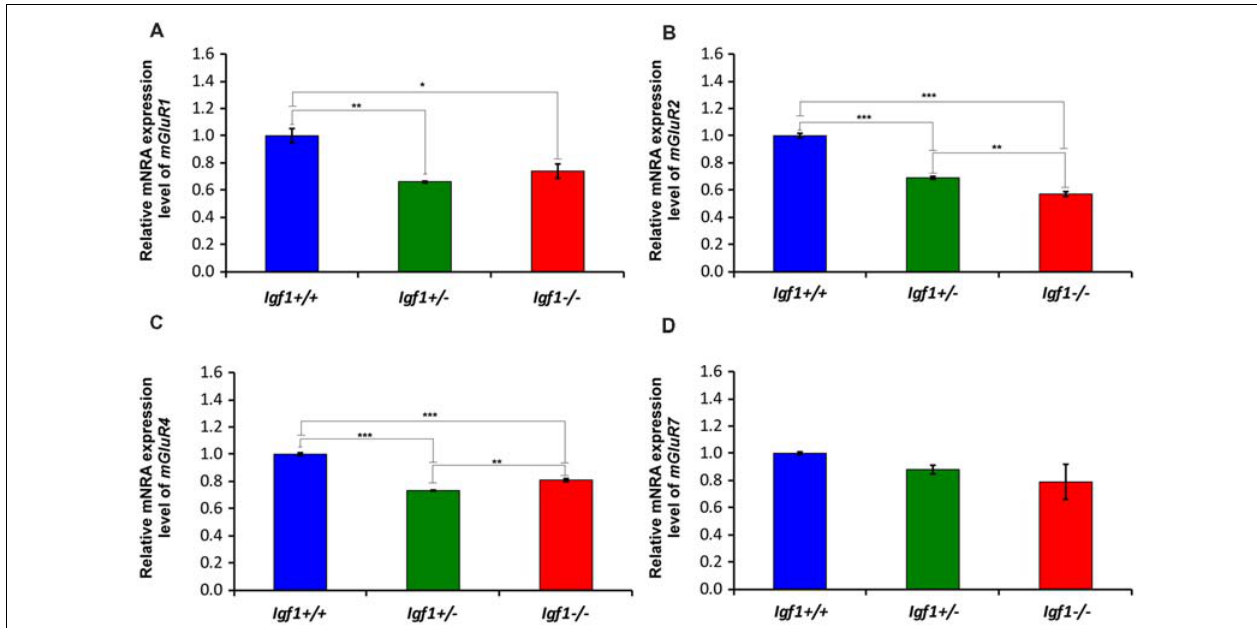
FIGURE 12 | The loss of IGF-1 leads to mGluR1 α , mGluR2 α , mGluR4 α and mGluR7 α downregulation. The mGluR1 α , mGluR2 α , mGluR4 α and mGluR7 α mRNA expression was determined by RT-qPCR in 4-month-old Igf1 − / − , Igf1 + / − and Igf1 + / + mice. The results demonstrate a decline in mGluR1 α (A) , mGluR2 α (B) , mGluR4 α (C) and mGluR7 α (D) expression in the Igf1 − / − mouse when compared with Igf1 + / − and Igf1 + / + mice. Note that the decrease in mgluR7 α expression in the Igf1 − / − mice was not statistically significant. Also, they show a significant downregulation of mGluR1 α (A) , mGluR2 α (B) and mGluR4 α in heterozygous mice compared with their age-matched control mice. The error bars indicate the standard deviations of the mean. Statistically significant differences among the animal groups were evaluated by one-factor ANOVA ( ∗ p < 0.05; ∗∗ p < 0.01, ∗∗∗ p <